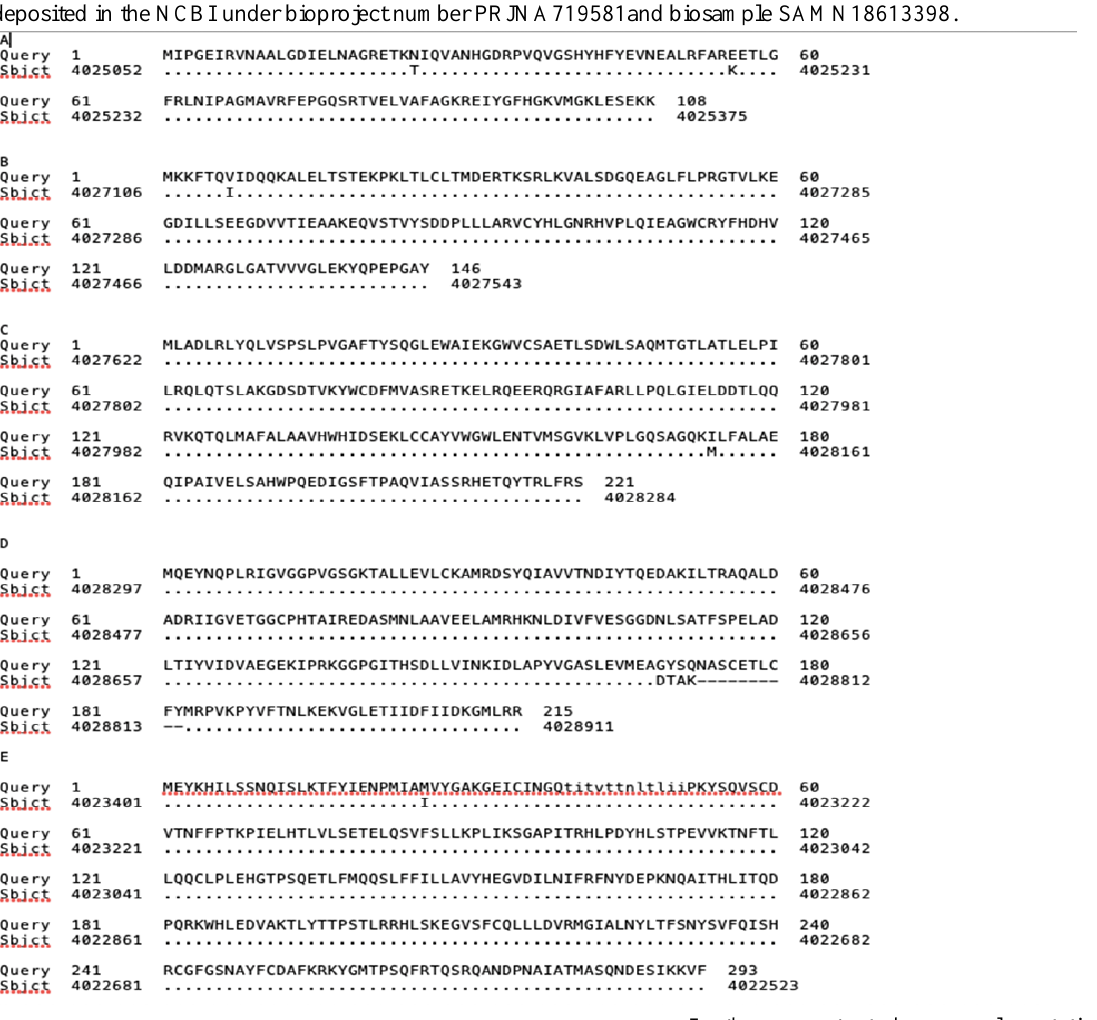
Figure 3. Mutations in amino acid sequence within (A) Beta subunit, (B) UreE, (C) UreF, (D) UreG, and (E) UreR. Our strain is the query strain compared to P. mirabilis strain HI4320 (sbjct). The genome sequence